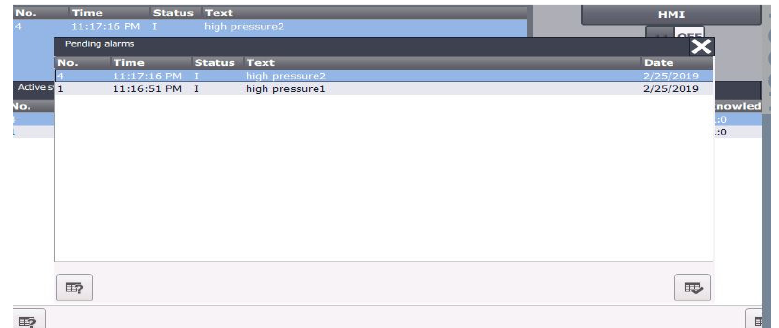
Fig. 13. Alarm in touch panel